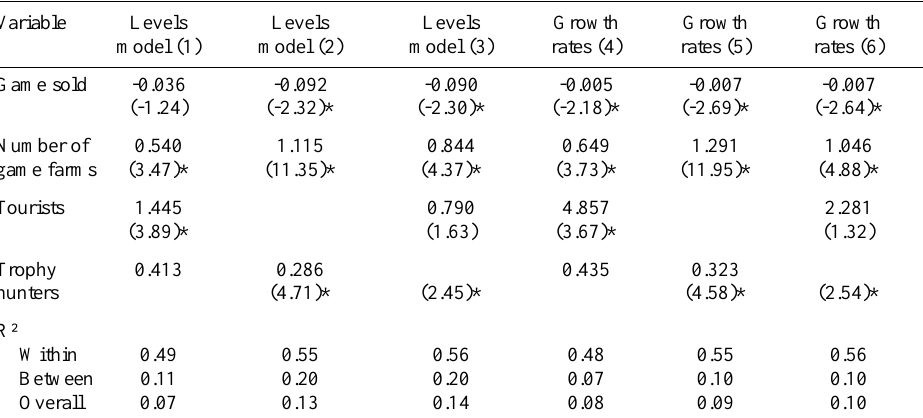
Table 3 Estimation